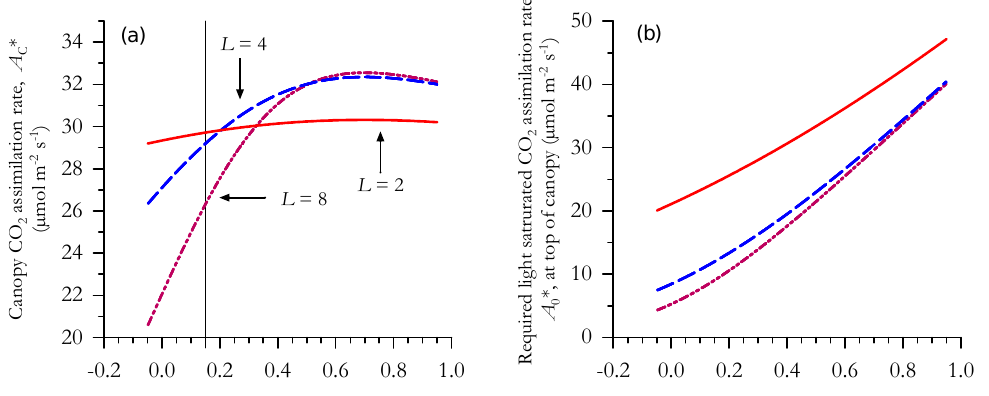
Fig. 1. Effect of variations in extinction coefficient for photosynthetic capacity, k P at a range of different leaf area indices, L , for an overall canopy photosynthetic capacity ( C C ) of 42µmolm − 2 s − 1 (ground area basis) and at an incoming photon irradiance of 2000µmolm − 2 s − 1 (a) Variations in canopy CO 2 assimilation rate (in the absence of any leaf respiration); (b) required CO 2 assimilation rate for the uppermost canopy leaves ( A ∗ ) in order to fulfill the requirements of Eq. 0